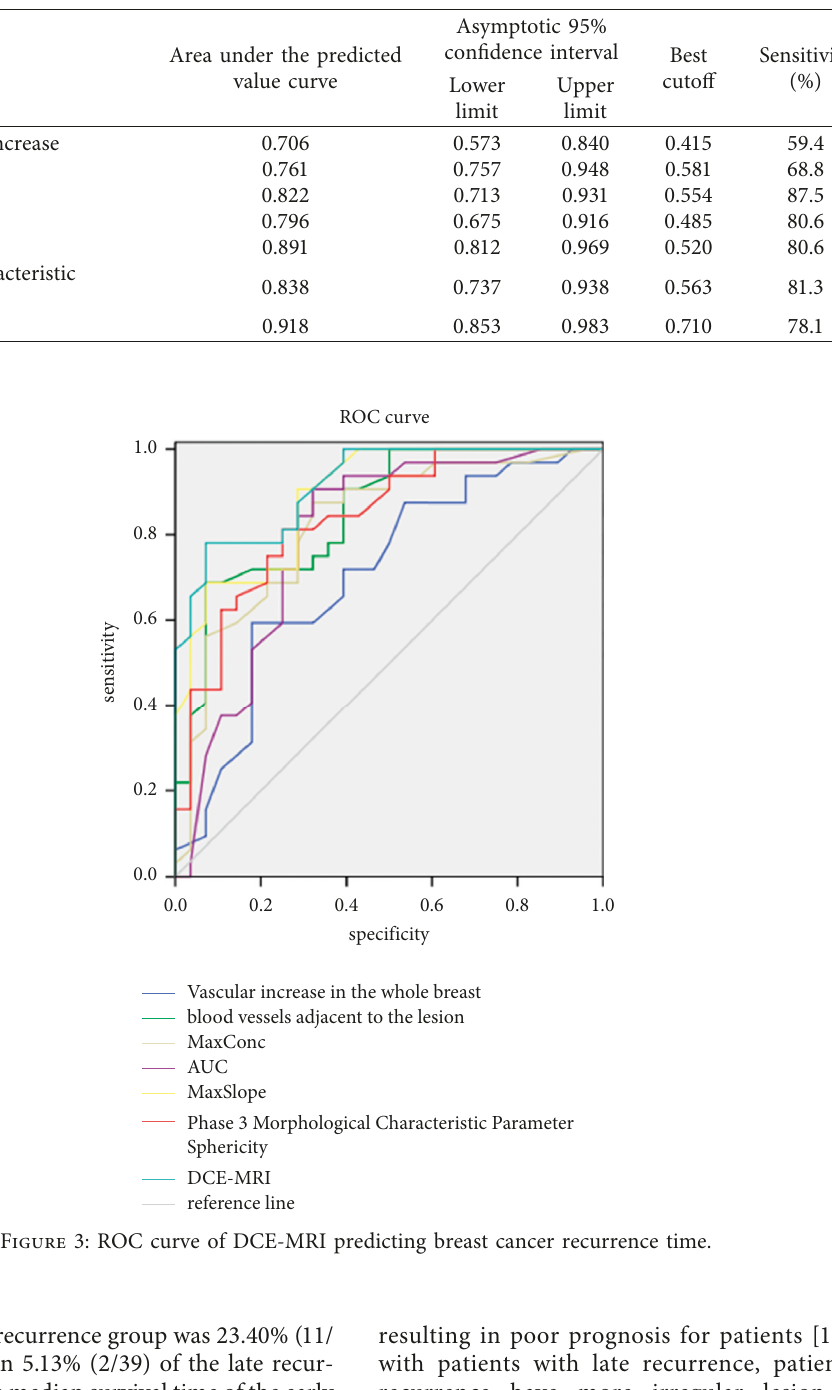
Table 3: The predictive value of DCE-MRI for breast cancer recurrence.